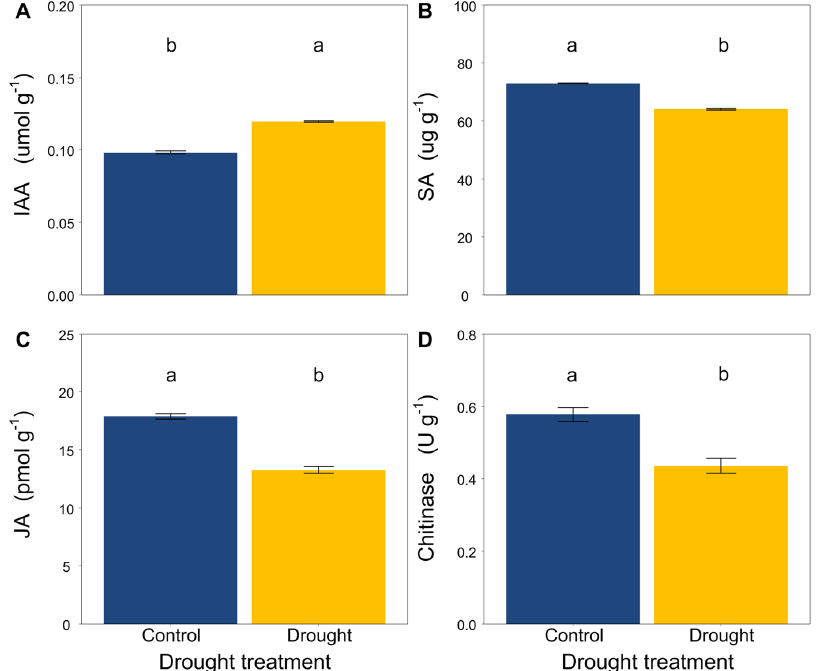
Figure 2. Effects of drought on ( A ) IAA, ( B ) SA, ( C ) JA content and ( D ) chitinase activity in roots of L. davurica . Mean ± SE are shown (n = 12). Within each panel, different lowercase letters indicate significant differences at p < 0.05 (Tukey’s HSD).